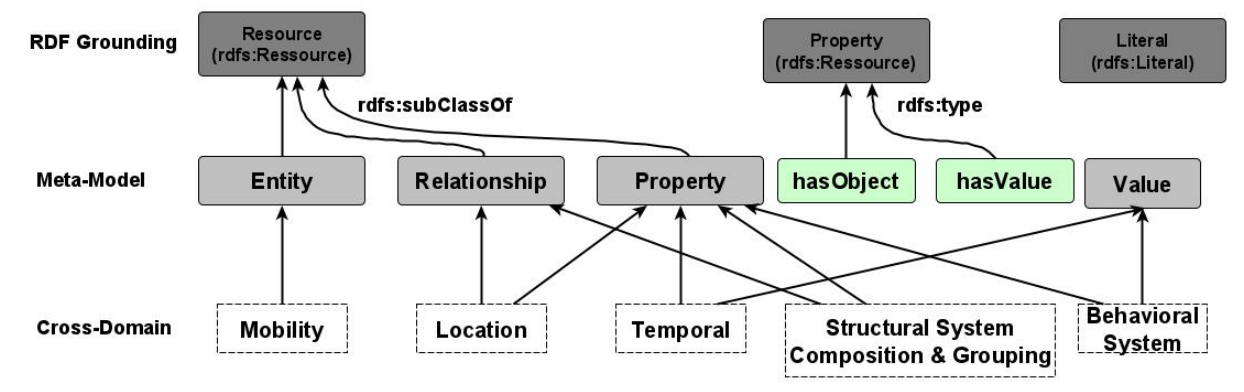
Figure 1. NGSI-LD Data Model